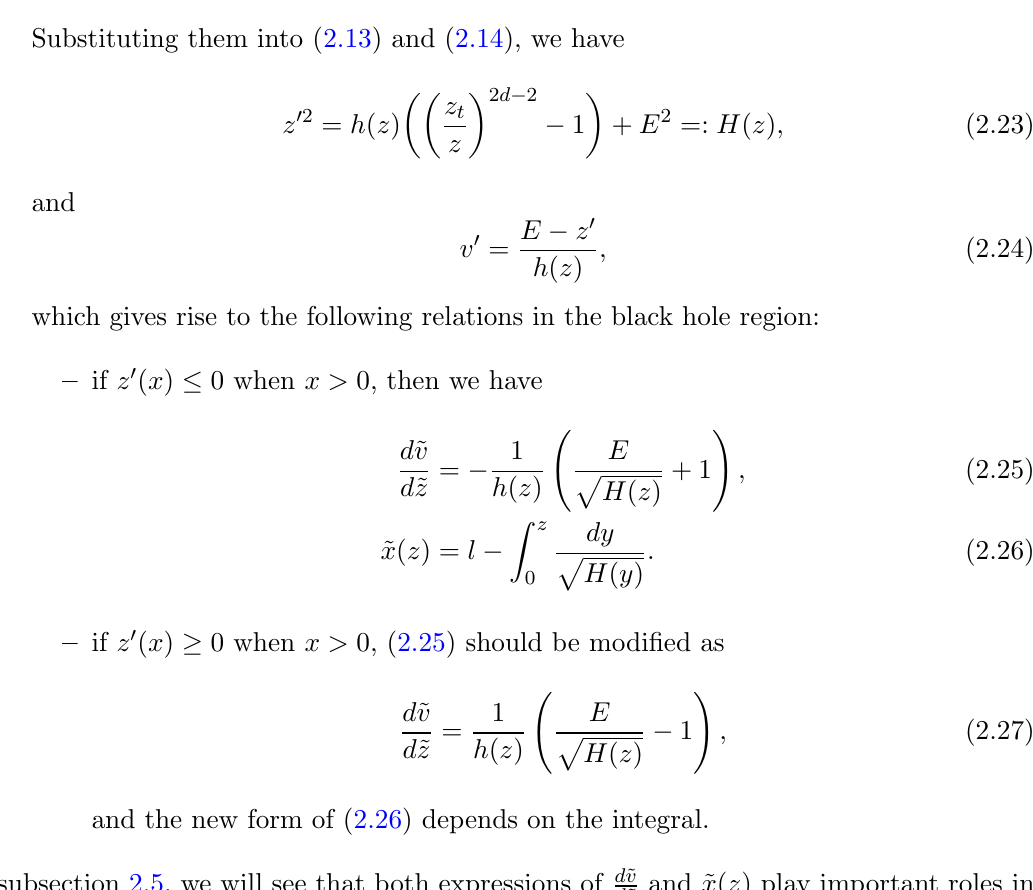
Figure 1 . For z c = z (cid:3) > z 0 and z t ! 1 , H ( z m ) = 0, and H ( z ) decreases from z = z (cid:3) c c as shown in (a), which means z ( x ) increases monotonically from z c and asymptotes to z m . The corresponding con(cid:12)guration of the critical surface is shown in